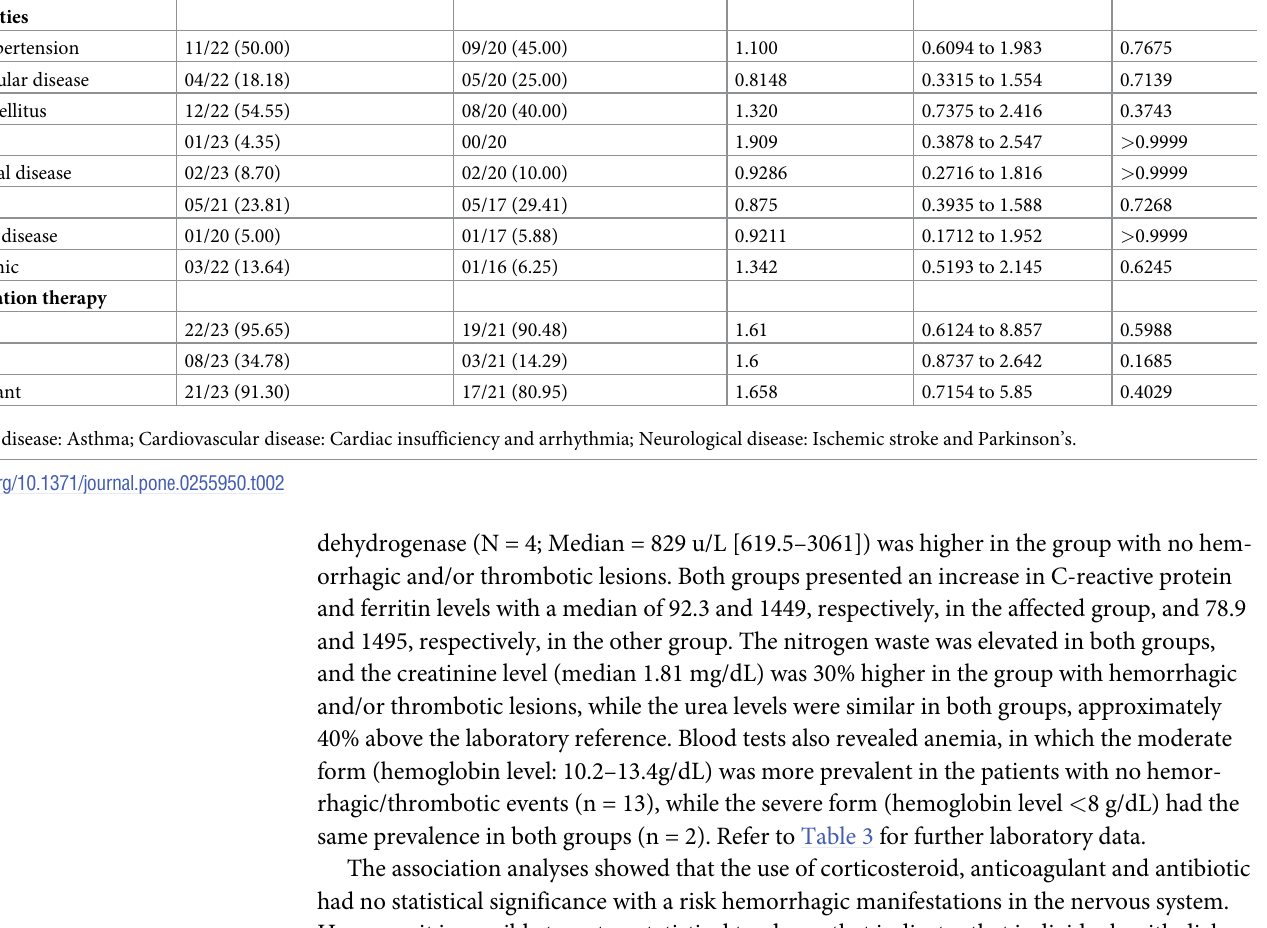
Table 2. Assessment of clinical data between study groups. Clinical